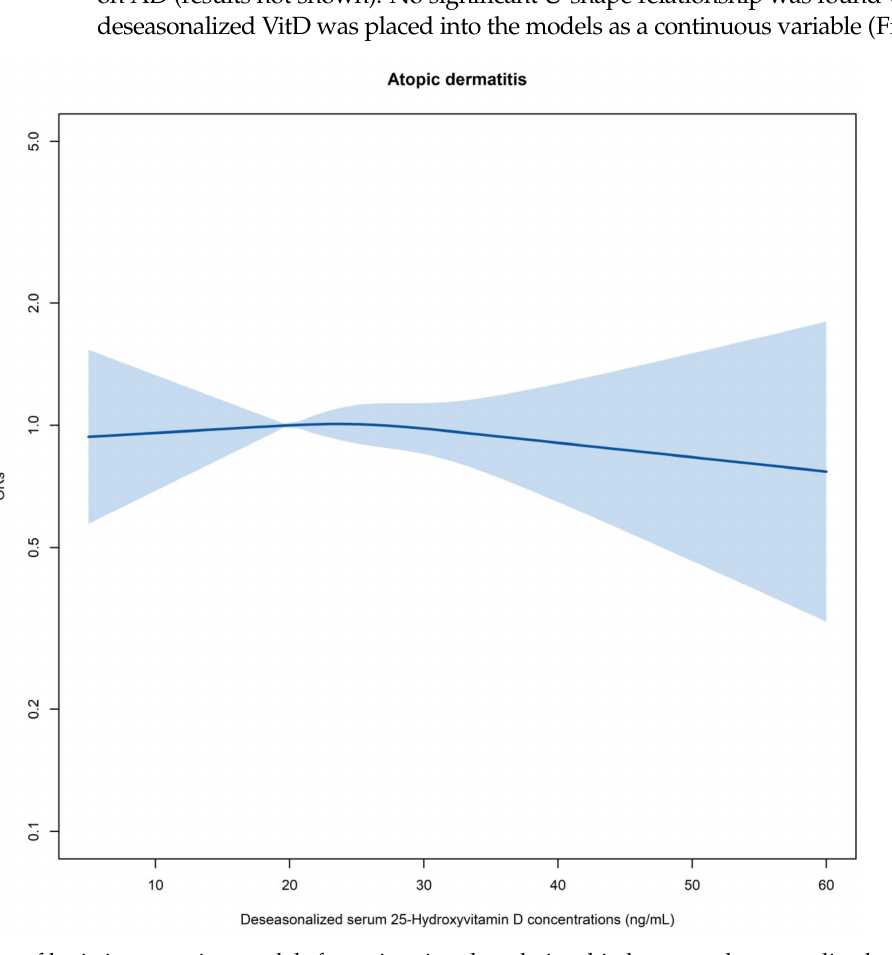
Figure 2. Summary of logistic regression models for estimating the relationship between deseasonalized vitamin D and atopic dermatitis in early childhood. Deseasonalized vitamin D was treated as a continuous variable. Model adjusted for all confounders listed in Table S1. Reference for ORs: 20 ng/mL. Shaded bands: 95% confidence limits for ORs. ORs: odds